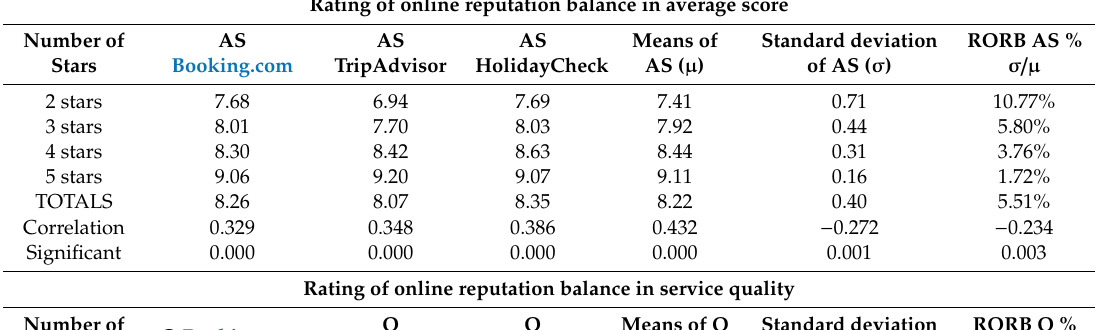
Table 1. Rating of online reputation balance in the South of Gran Canaria destination. Rating of online reputation balance in average